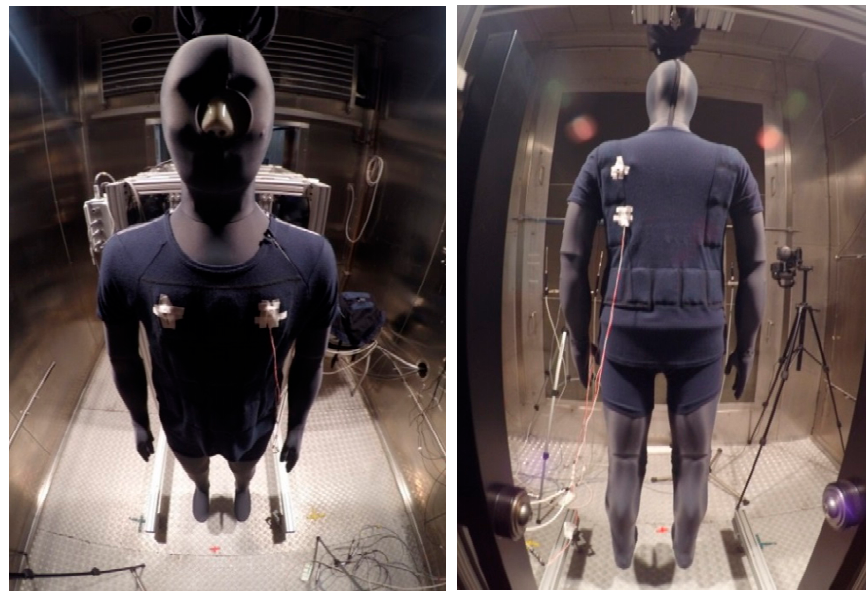
Figure 5. The manikin wearing type A undergarments.